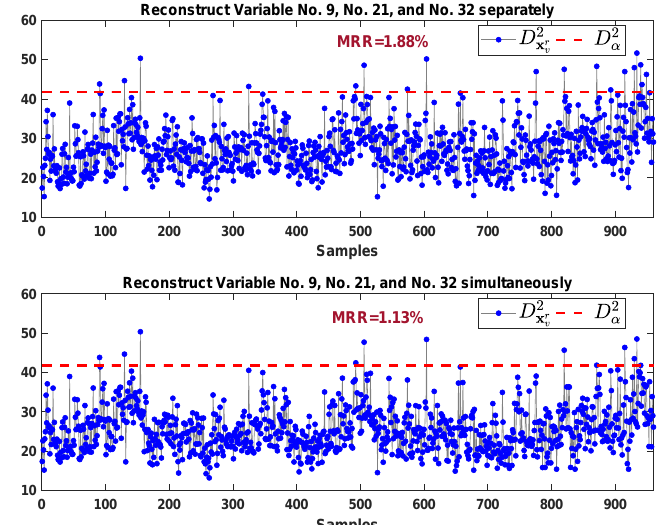
Figure 23. The fault detection results of reconstructed samples by estimating and replacing variable No.9, No.21, and No.32 for fault 14 of